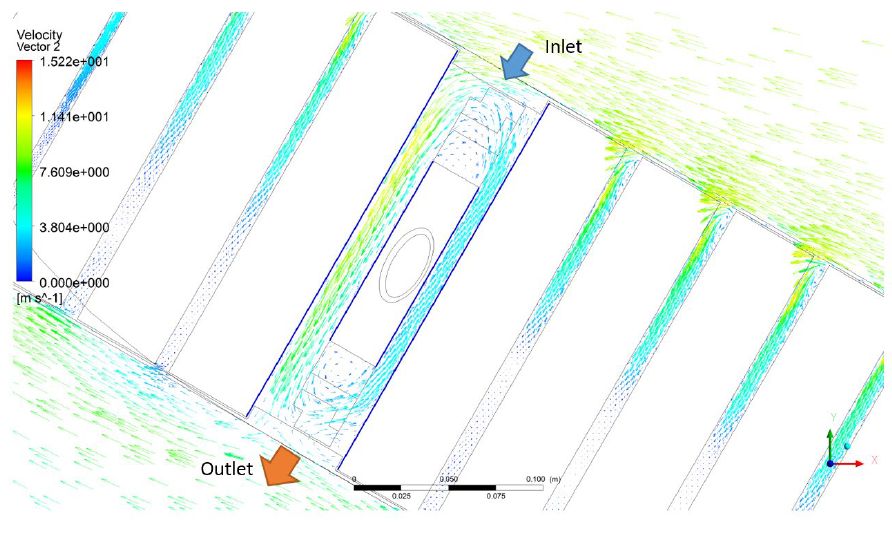
Figure 20. Velocity vectors of gap air flow near engine casing.